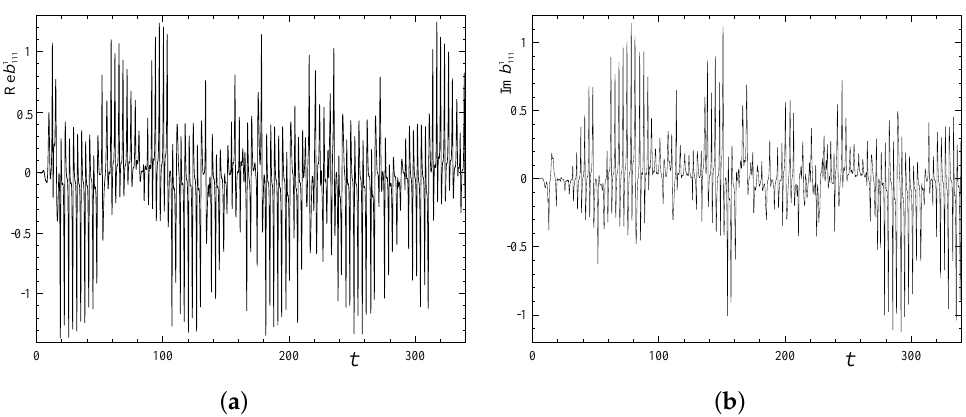
Figure 12. Temporal behaviour of the Fourier coefficients Re ˆ b 1